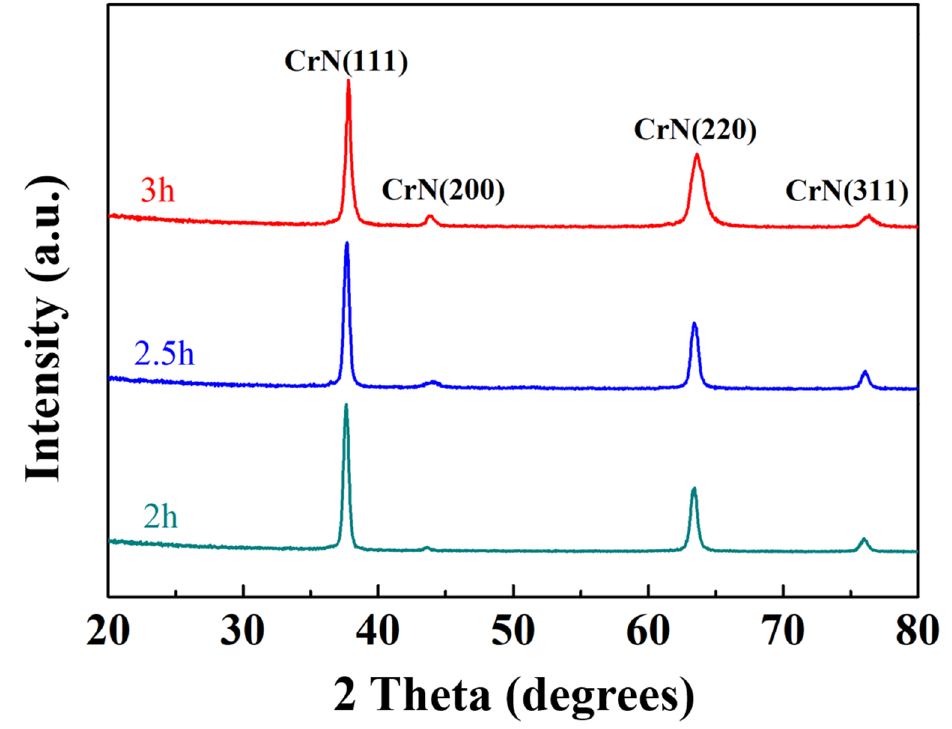
Figure 6. XRD patterns of CrN films deposited under different sputtering time.